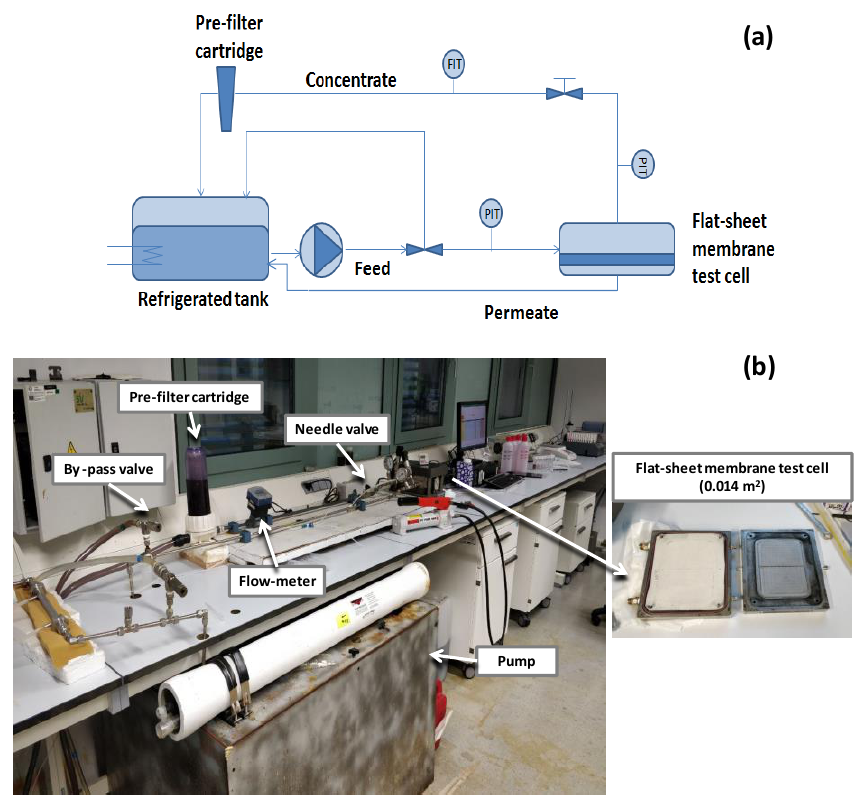
Figure 1. ( a ) NF and RO membrane filtration experimental set-up scheme and ( b ) a picture of the experimental set-up, for the evaluation of polyphenol rejection.